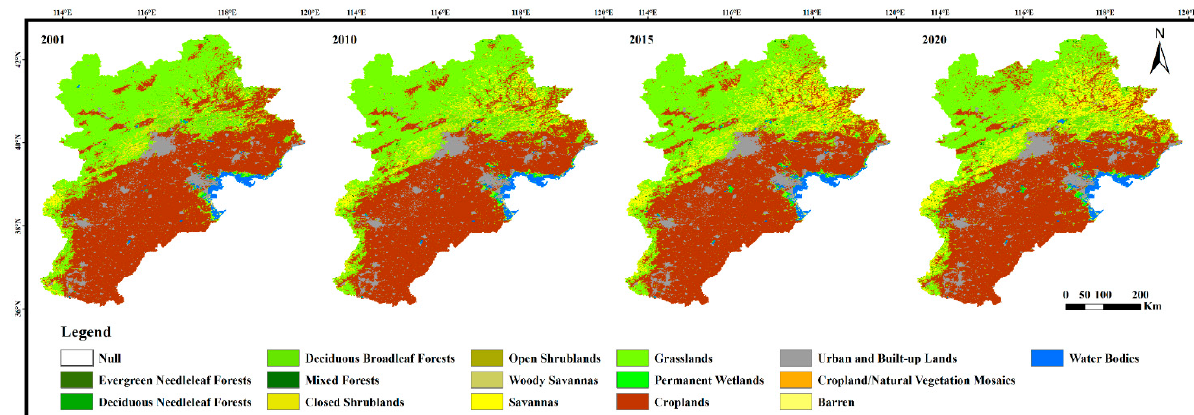
Figure 4. The MODIS IGBP landcover of Beijing–Tianjin–Hebei in 2001, 2010, 2015, and